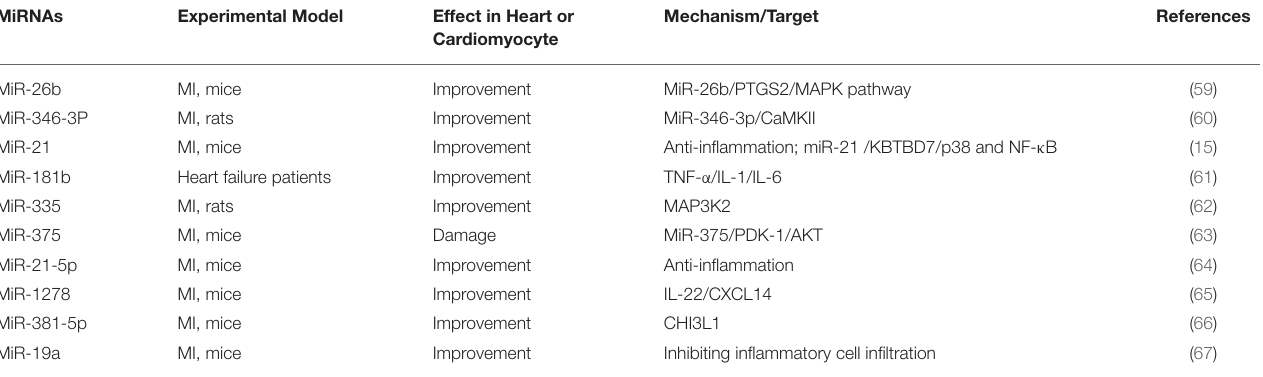
TABLE 4 | Summary of studies on miRNA regulating MI by inflammation in the past 5 years.